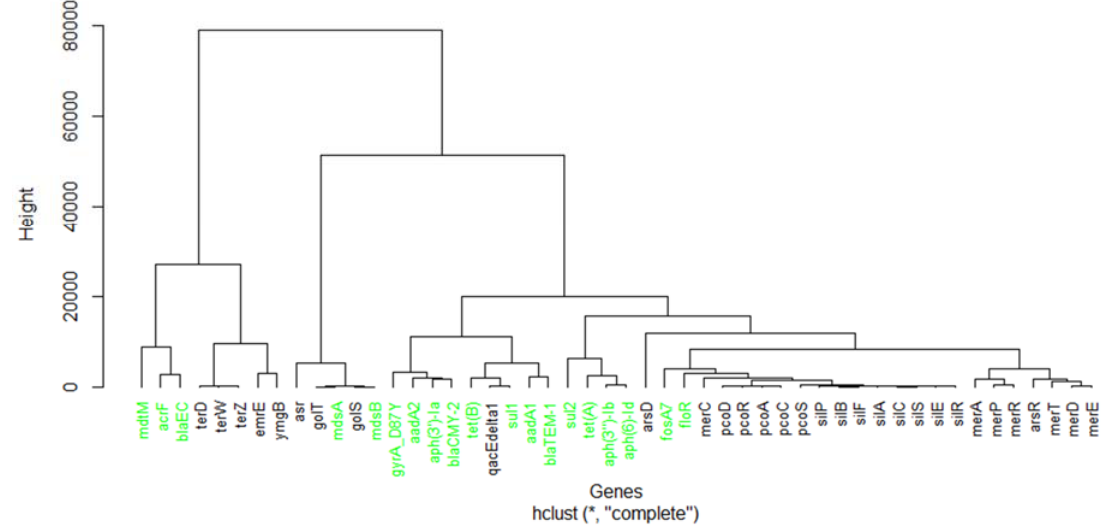
Figure 5. The hierarchical clustering tree for stress and AMR genes from the US. Black text represents stress response genes and green text represents AMR genes.